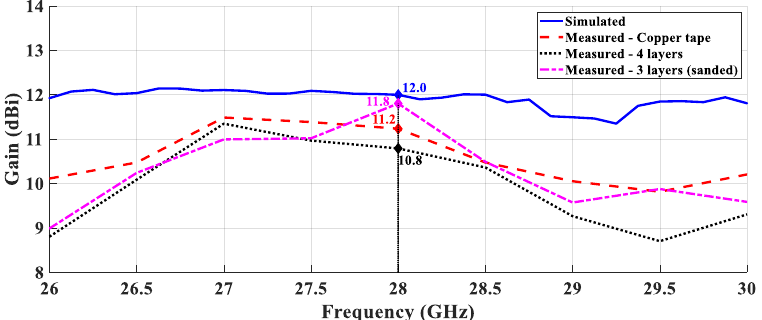
Figure 14. Comparison between simulated and measured gain over the frequency—PLA structure covered with copper.